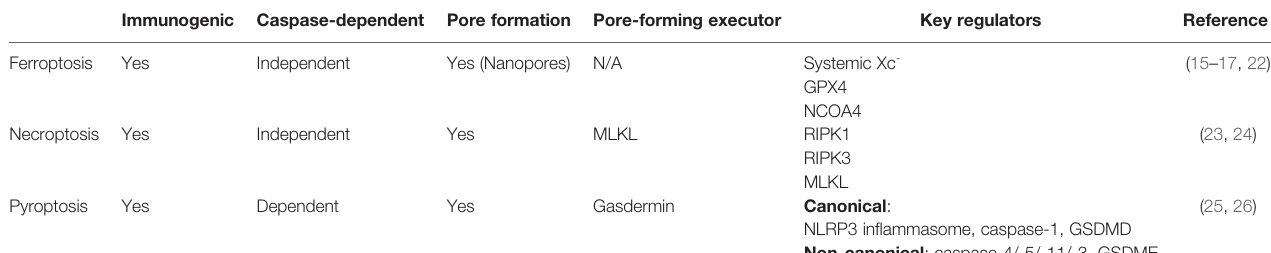
TABLE 1 | The biological features of ferroptosis, necroptosis and